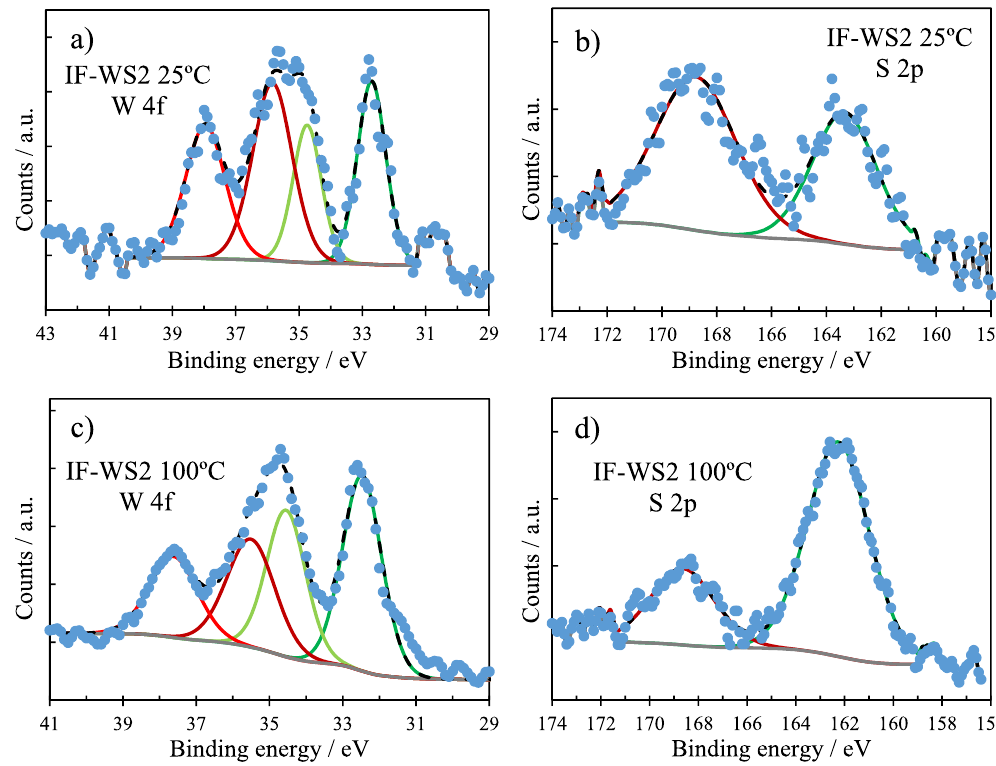
Figure 10. XPS spectra recorded inside the wear track of Al-IF-WS 2 composites tested at 25 °C and 100 °C; ( a , c ) W 4f spectra; ( b , d ) S 2p spectra.